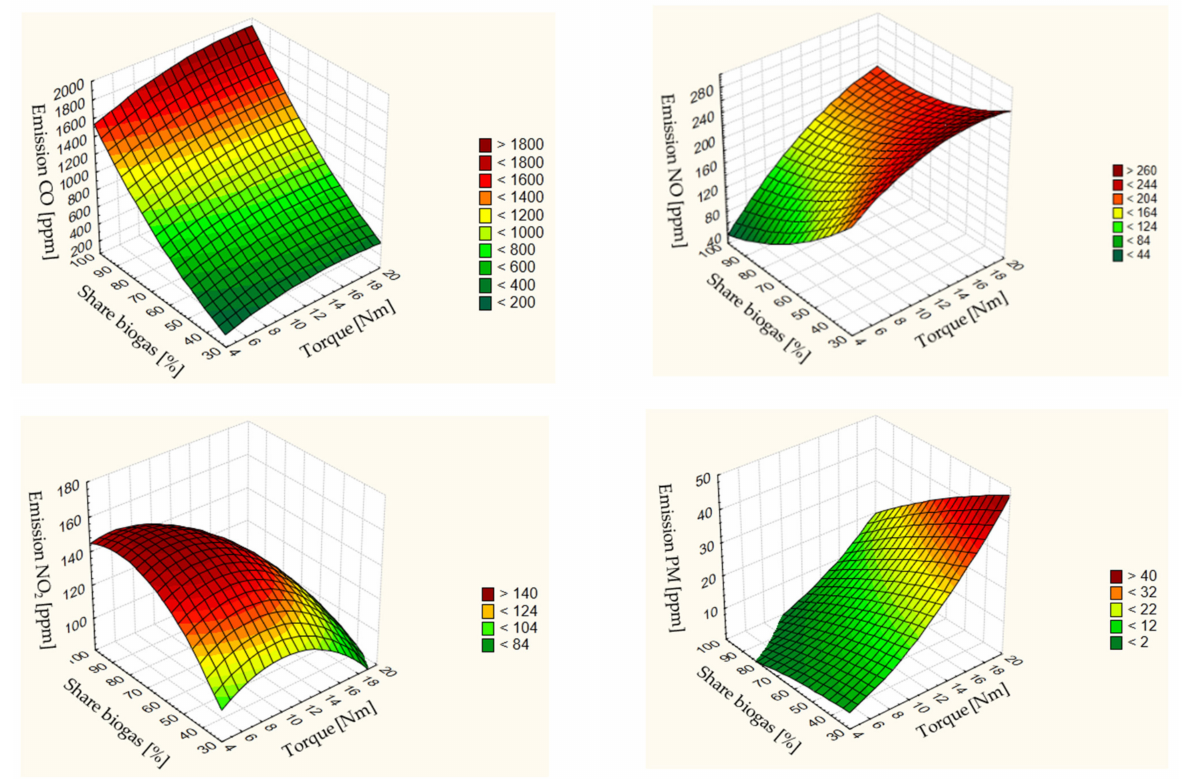
Figure 7. Emission of CO, NO, NO 2 , and PM in the mixture of DF and BG at variable load.